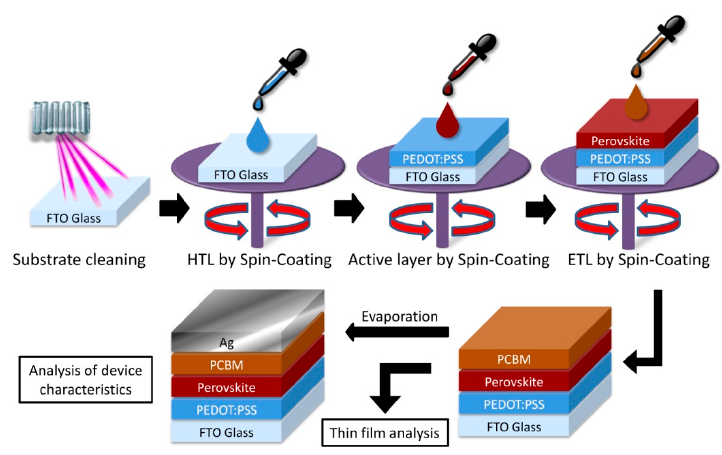
Figure 2. The fabrication process of a perovskite solar cell.